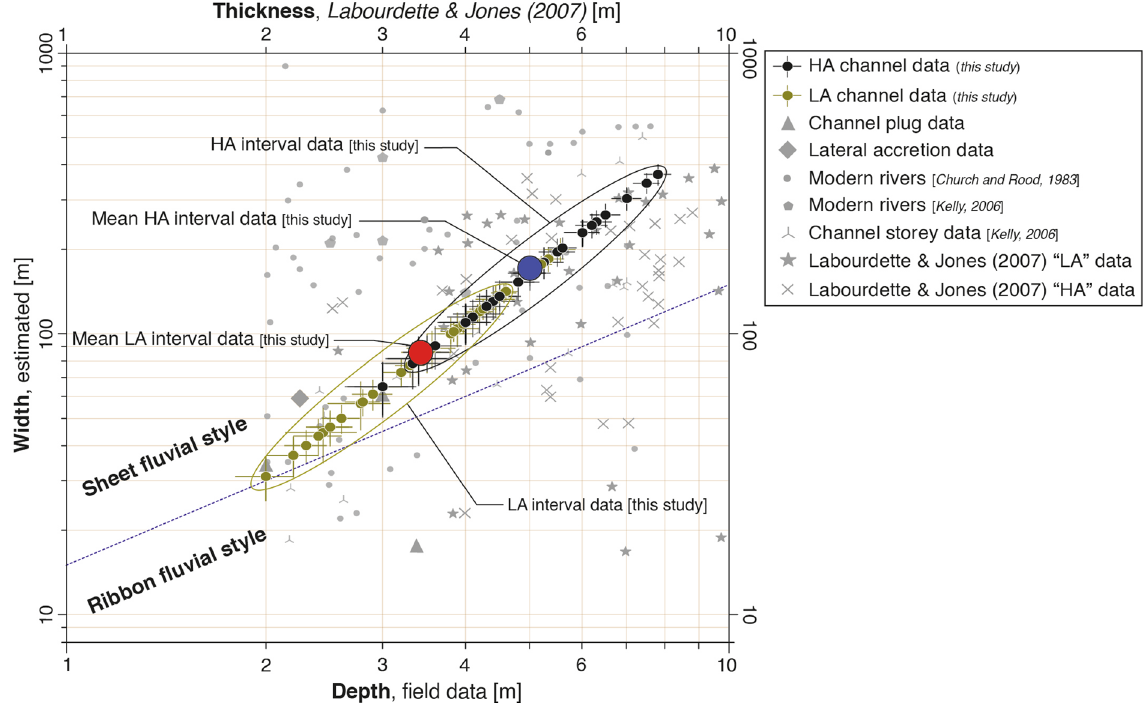
Figure 6. Comparison between modern river channel width and depth to estimates from this study. A cross plot with width and depth of modern rivers (data from 47 and 48 having grain sizes between 5 – 45 mm and flow depths of 2 – 7.5 m which is the range of grain sizes and depths measured at Olson. Such a plot also allows the prediction of fluvial style during HA and LA